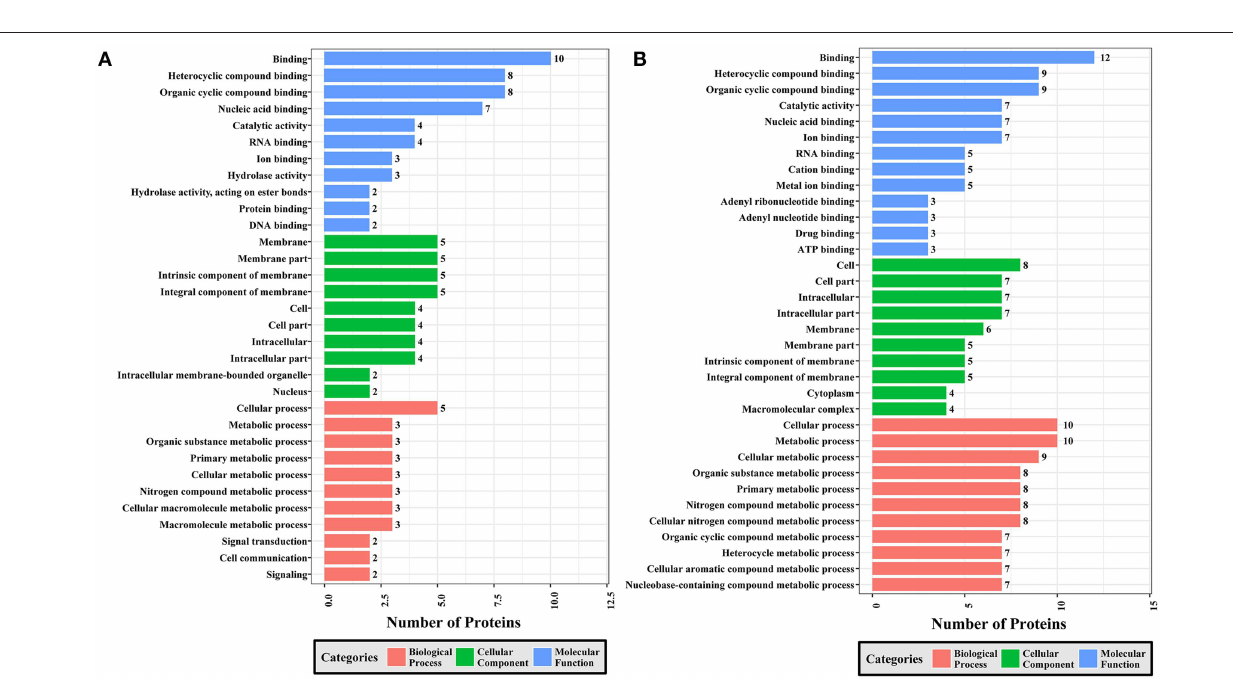
pathways, and included 6, 3, 3, 8, 5, and 8 phosphoproteins, respectively ( Figure 9B ). There were two significantly enriched pathways in PYS vs. RH (viral carcinogenesis and